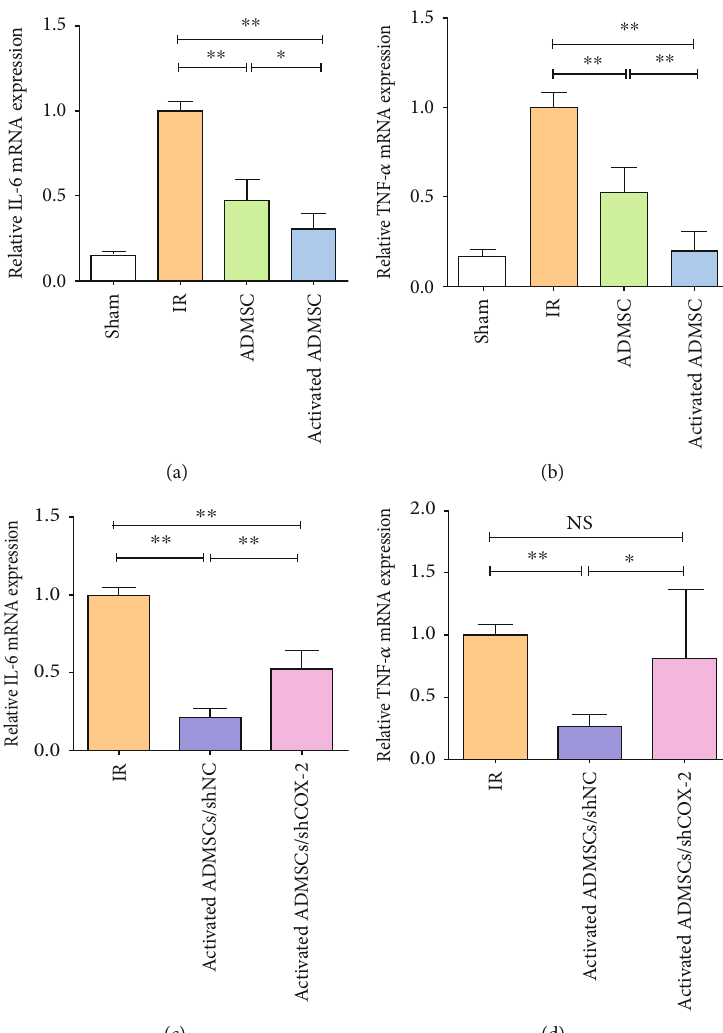
Figure 5: Activated ADMSC decreased in fl ammation in IR-injured intestinal tissue. (a, c) Expression of IL-6 in di ff erent groups. (b, d) Expression of TNF- α in di ff erent groups ( ∗ P < 0 : 05 , ∗∗ P < 0 : 01 , NS: no statistical signi fi cance, Bonferroni ’ s multiple